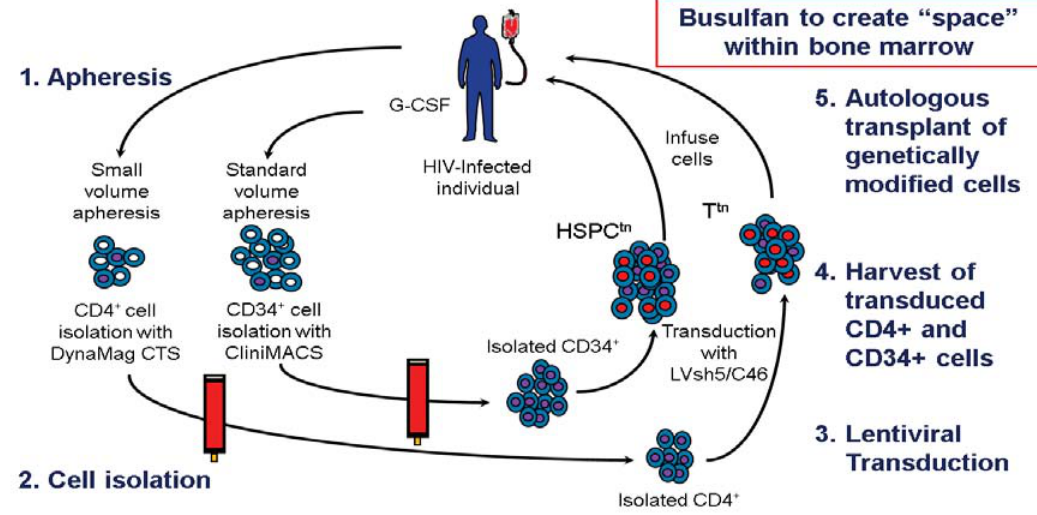
Figure 3. Schematic of the process for engineering protection from HIV-1 into human recipients via LVsh5/C46 mediated modification of CD4 + T lymphocytes and CD34 + HSPC. 1 . Apheresis, small or standard volume respectively, to obtain CD4 + T cells or CD34 + hematopoietic stem cells; 2 . Cell isolation using CliniMACS and DynaMag CTS bead separation; 3 . Lentiviral vector transduction with LVsh5/C46 in appropriate cytokines — CD3/CD28 bead stimulation and IL2 for T cells, stem cell factor, thrombopoietin and FLT-3 ligand for hematopoietic stem cells; 4 . Harvest of transduced cells and freezing; 5 . Following release testing, transplantation of genetically modified cells. Busulfan (4 mg/kg or 8 mg/kg) is administered pre cell infusion to make bone marrow space for introduced CD34 +